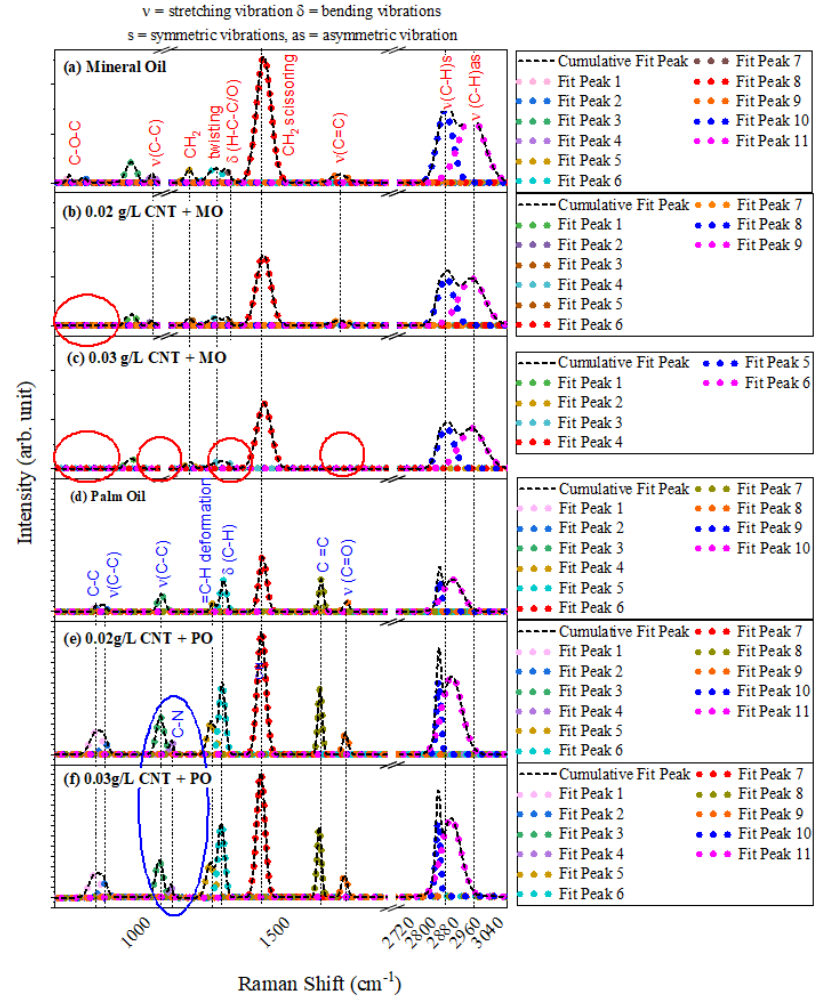
Figure 5. Multiple peak fitting of ( a ) mineral oil, ( b ) palm oil, ( c ) mineral oil with 0.02 g/L CNT, ( d ) mineral oil with 0.03 g/L CNT, ( e ) palm oil with 0.02 g/L CNT, ( f ) palm oil with 0.03 g/L CNT.